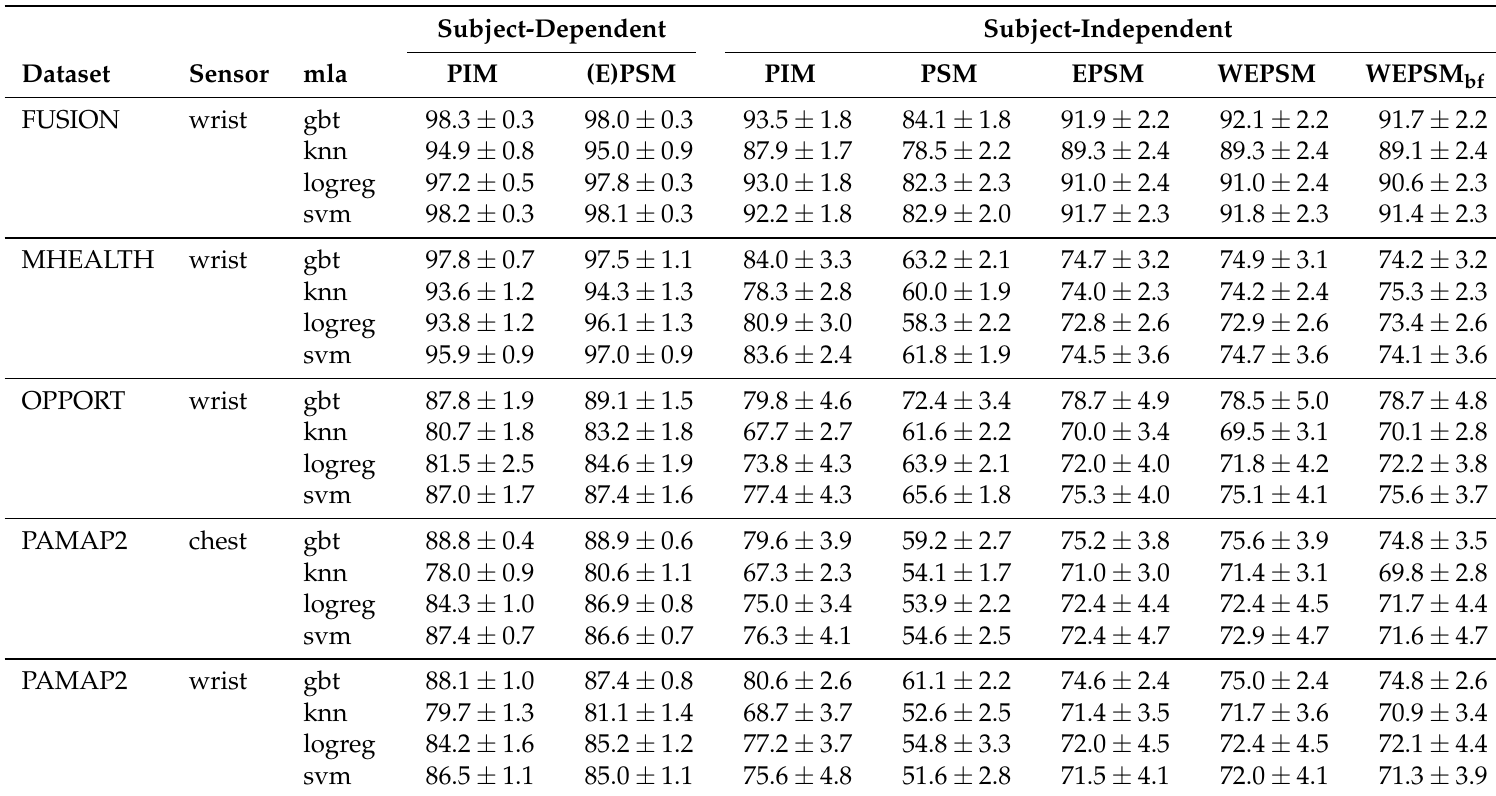
Table A1. Subject-dependent and subject-independent accuracy (%) ± standard error when learning algorithms (mla) are combined with a person-independent model (PIM) a person-specific model (PSM), an unweighted ensemble of PSMs (EPSM), a κ -weighted EPSM (WEPSM), or a baseline-feature-weigthed EPSM (WEPSM bf